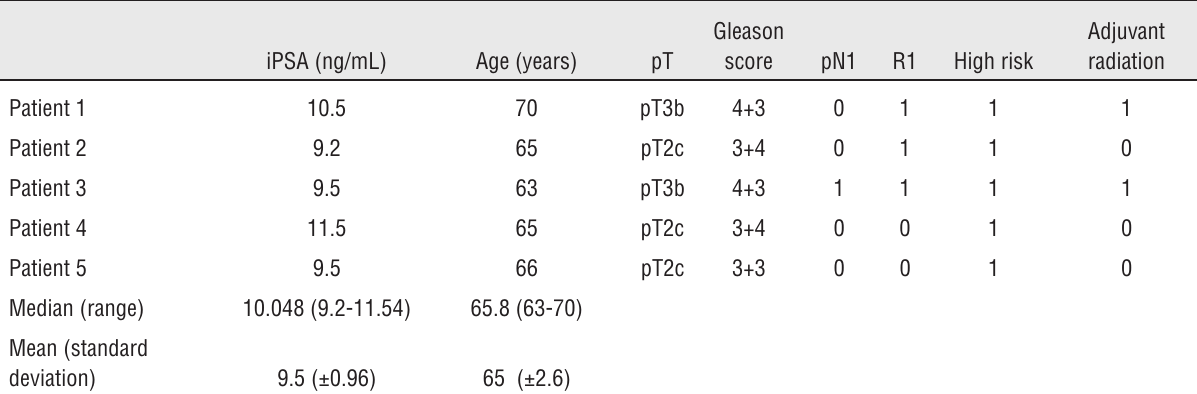
Table 1 - Patients’ characteristics (n=5).